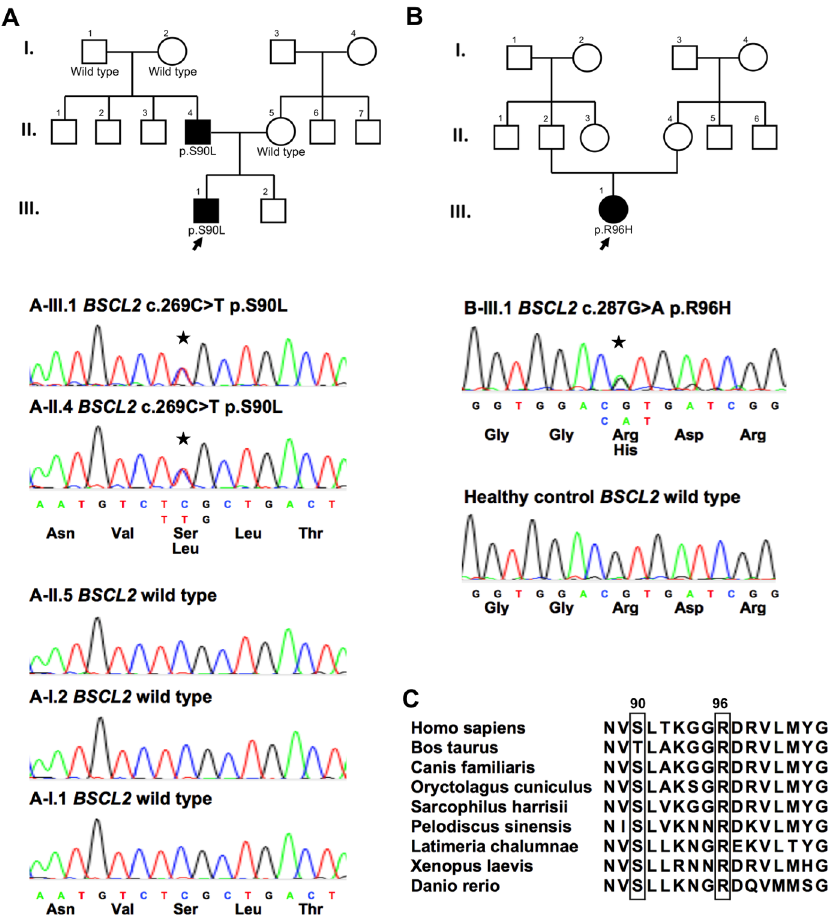
Fig 1. The pedigrees and sequencing data of the two families carrying BSCL2 mutations. (A) The pedigree and the electropherograms of the individuals of the family carrying the BSCL2 p.S90L (c.269C > T) mutation. The proband (III-1) is denoted by an arrow. Filled symbols represent affected members with neuropathy, open symbols indicate unaffected individuals, circles stand for female, and squares stand for male. (B) The pedigree and the electropherogram of the patient carrying the BSCL2 p.R96H (c.287G > A) mutation. (C) The BSCL2 p.S90L and p.R96H mutations reside in an evolutionarily conserved region, as shown by aligning the amino acid sequences of seipin protein orthologs from various species.